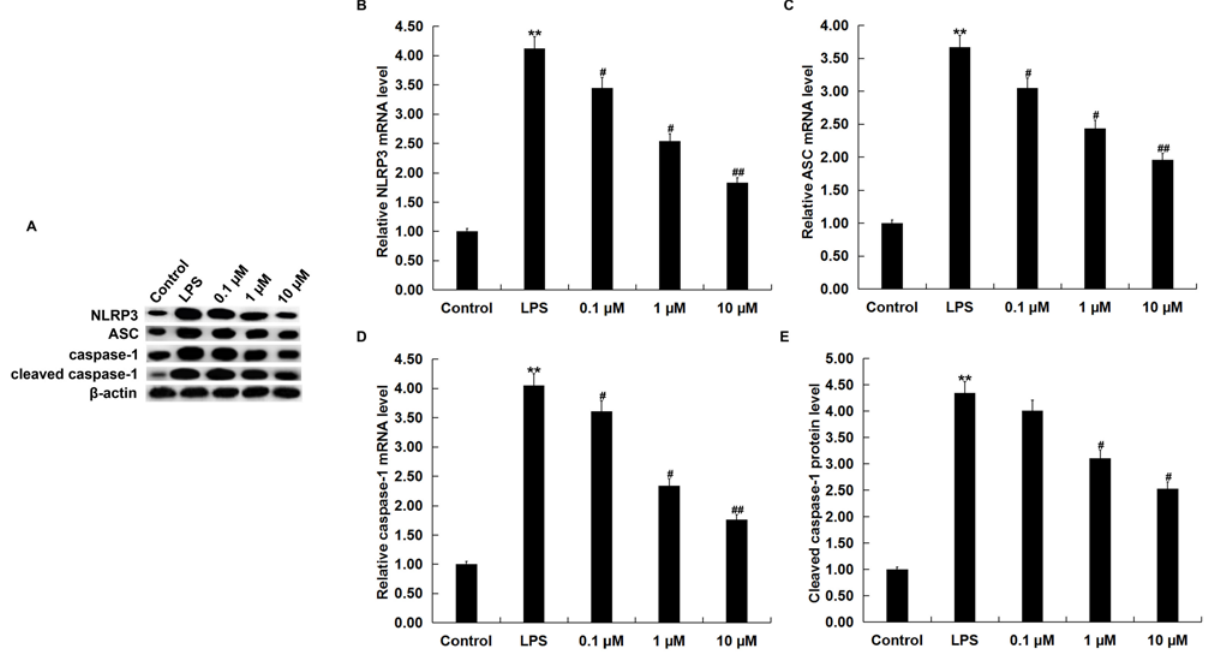
Figure 5: Effects of NGR1 on NLRP3 inflammasome in LPS-treated RAW264.7 cells. In addition to an untreated control sample, RAW264.7 cells were pretreated with various concentrations of NGR1 (0.1, 1, and 10 µ M) for 2 h and then treated with 1 µ g/ml LPS at 37˚C for 24 h. A: the protein levels of NLRP3, ASC, cleaved caspase-1, and caspase-1 were detected using western blotting; B, C, D: the mRNA levels of NLRP3, ASC, and caspase-1 were detected using qRT-PCR; E: the relative protein level of cleaved caspase-1 was analyzed and presented as fold of control. Data were expressed as the mean ± SD. **p<0.01 vs. control group; #, ## p<0.05, 0.01 vs. LPS treatment alone